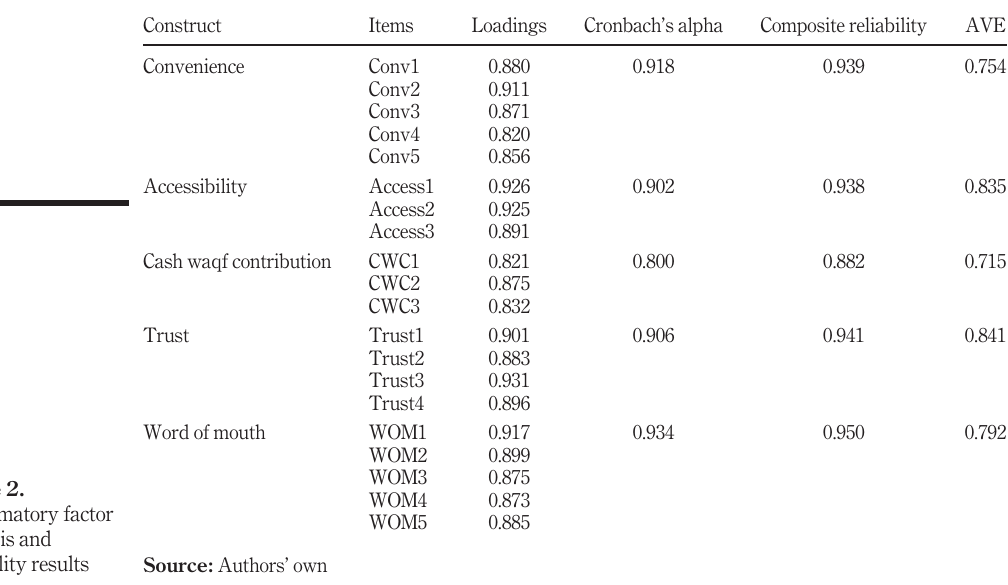
Table 2. Con fi rmatory factor analysis and reliability results